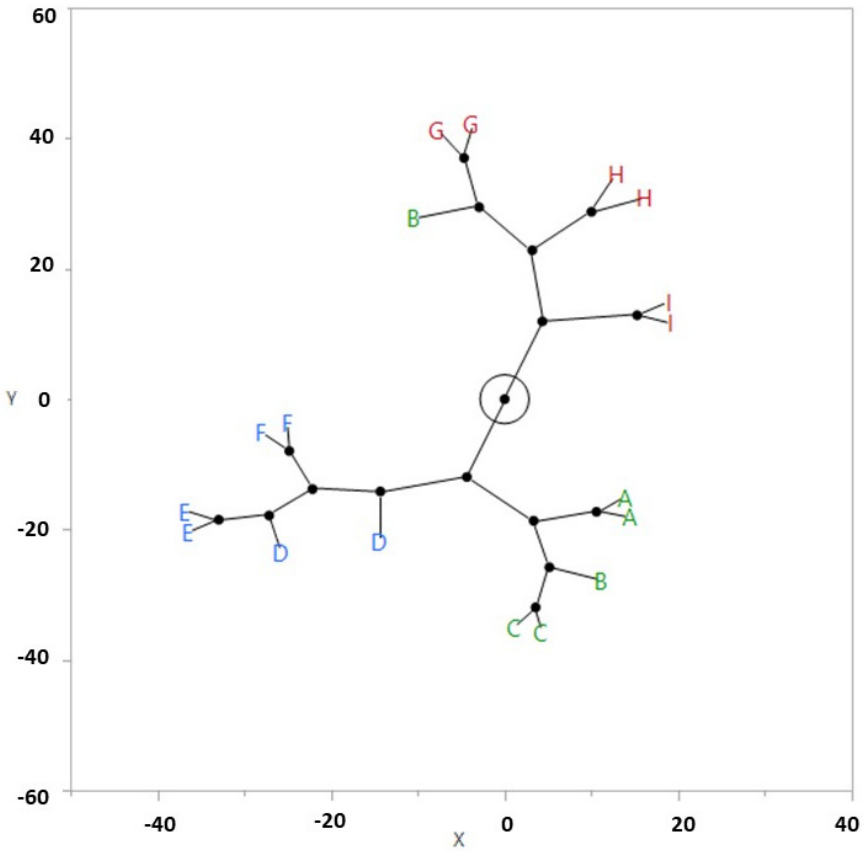
Figure 2. Constellation diagram from HCA on physiochemical and chromatographic results. Green: